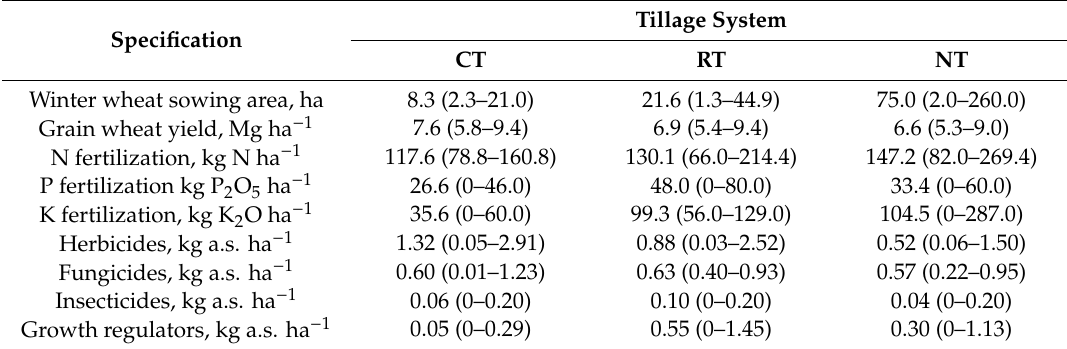
Table 3. Production characteristics of winter wheat cultivation under conventional tillage (CT), reduced tillage (RT), and no-tillage (NT) systems of the studied farms (averages from the study years with min–max range in